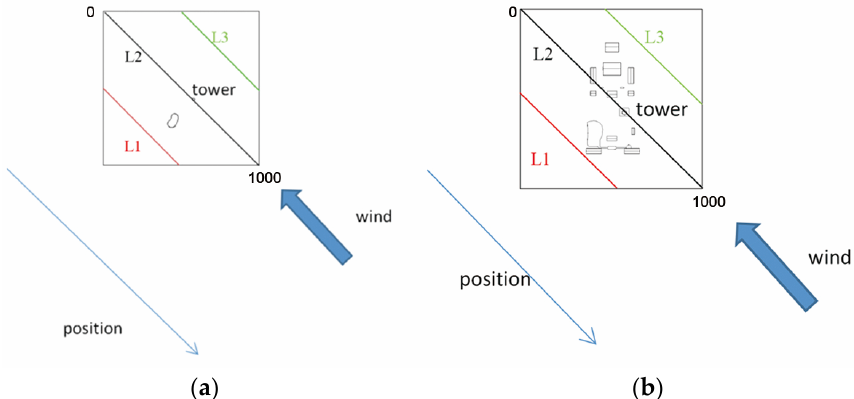
Figure 8. Before and after the transformation: ( a , b ) observation line location diagrams.